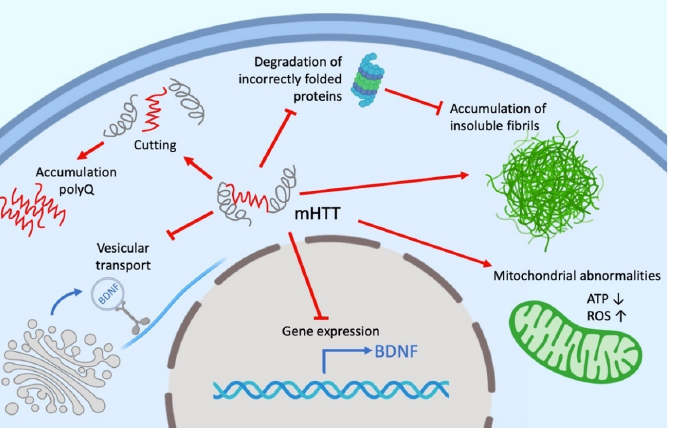
Figure 1. Possible mechanisms of mHTT cellular toxicity (enlarged polyglutamine fragment is shown in red). The toxic effect includes inhibition of proteasome and autophagic degradation, disruption of vesicular transport, effects on mitochondrial physiology, transcription of BDNF (brain ‐ derived neurotrophic factor) and mitochondrial proteins. Polyglutamine fragments obtained during the degradation of mHTT itself also have a toxic effect. Red arrows indicate a stimulating effect, red T sticks indicate an inhibitory effect. Figure was created with BioRender.com (accessed on 25 October 2022).